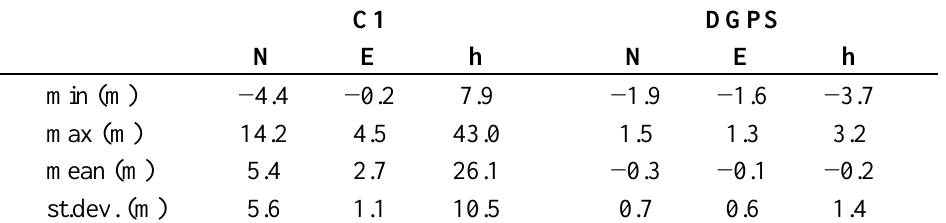
Table 1. Statisticsof autonomous and DGPS solutions under normal conditions.